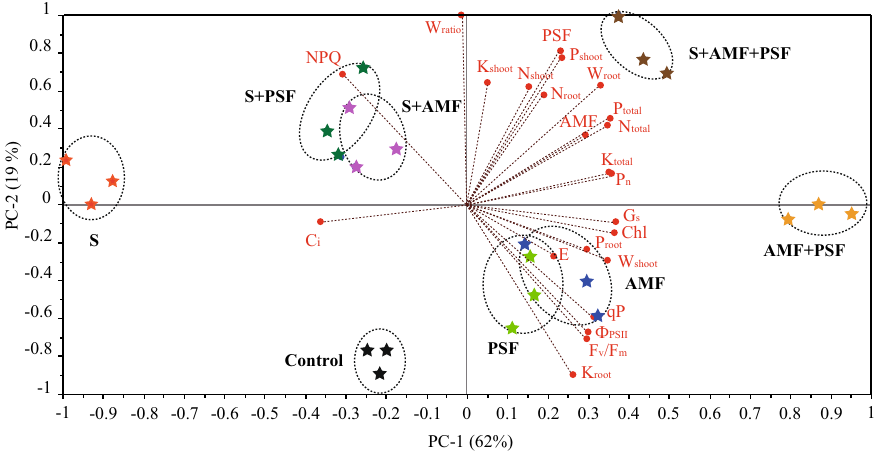
Figure 4. Principal component analysis of the studied parameters of different treatments of beach plum under saline and non-saline conditions. S, Salinity; AMF, arbuscular mycorrhizal fungi; PSF, phosphate-solubilizing fungi; W shoot , shoot dry weight; W root , root dry weight; W ratio , root/shoot dry weight ratio; P shoot , phosphorous uptake of shoots; P root , phosphorous uptake of roots; P total , phosphorous uptake of the total plant; N shoot , nitrogen uptake of shoots; N root , nitrogen uptake of roots; N total , nitrogen uptake of the total plant; K shoot , potassium uptake of shoots; K root , potassium uptake of roots; K total , potassium uptake of the total plant; Chl, chlorophyll; C i , intercellular CO 2 concentration; E, transpiration rate; F v /F m , the maximal quantum yield of PSII in dark- adapted state; G s , stomatal conductance; NPQ, nonphotochemical quenching; P n , net photosynthetic rate; qP, photochemical quenching coefficient; and Ф PSII , effective quantum yield of